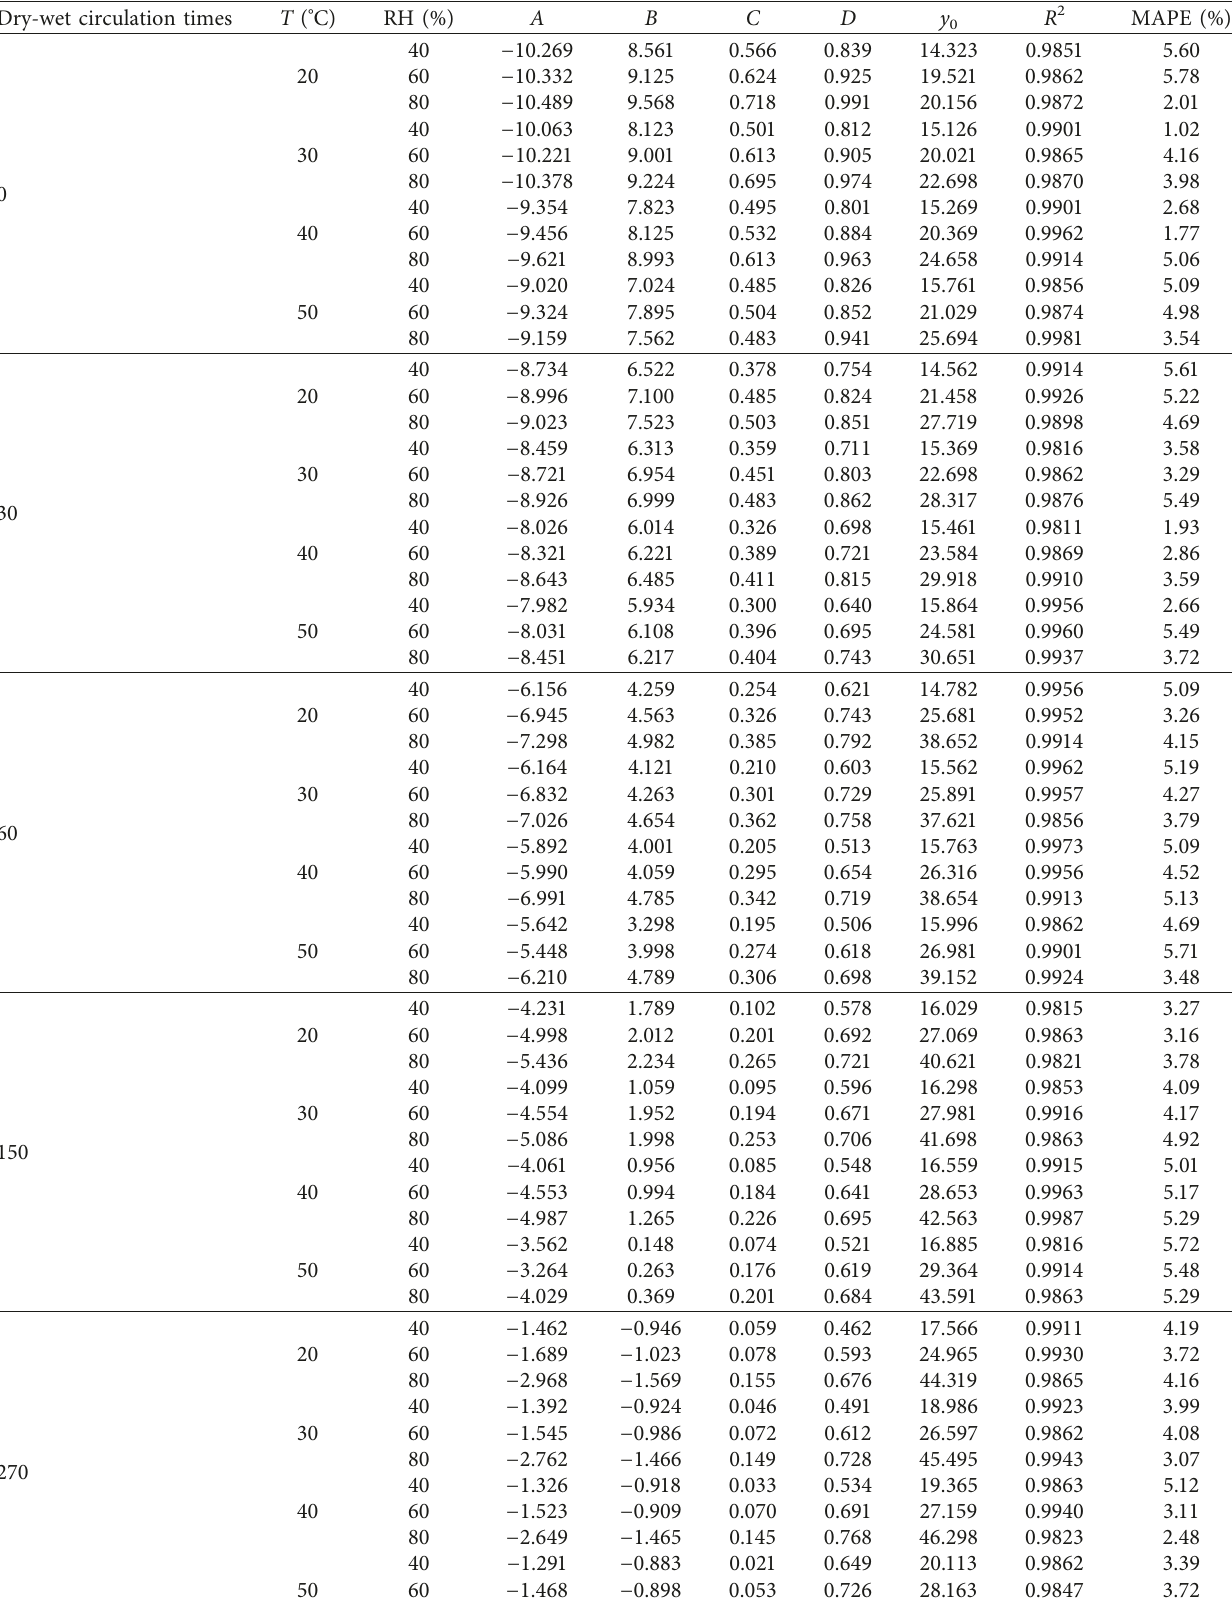
Table 3: Moisture absorption kinetic parameters affected by temperature and relative humidity. Dry-wet circulation